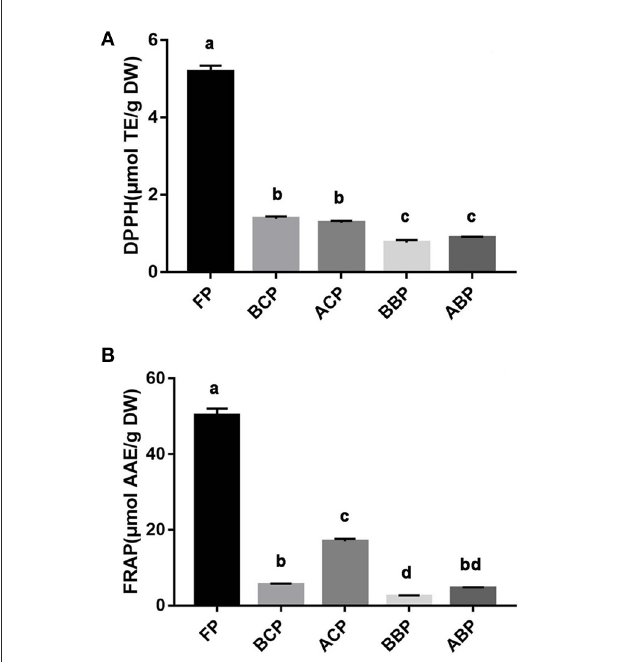
FIGURE3 Antioxidant capacity of different fractions of hazel leaf (A) DPPH assay, (B) FRAP assay, data are presented as means ± SD ( n = 3), values not sharing a common superscript letter denote significant difference ( p <